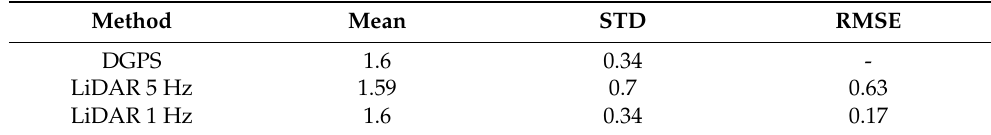
Table 7. Comparison of speed filtering